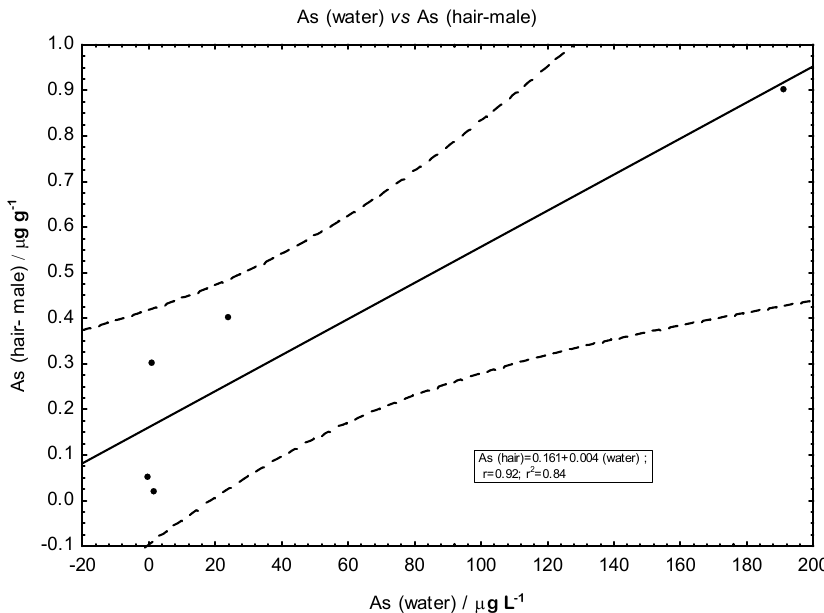
Figure 4. Relationship between median arsenic concentrations in water and hair in male